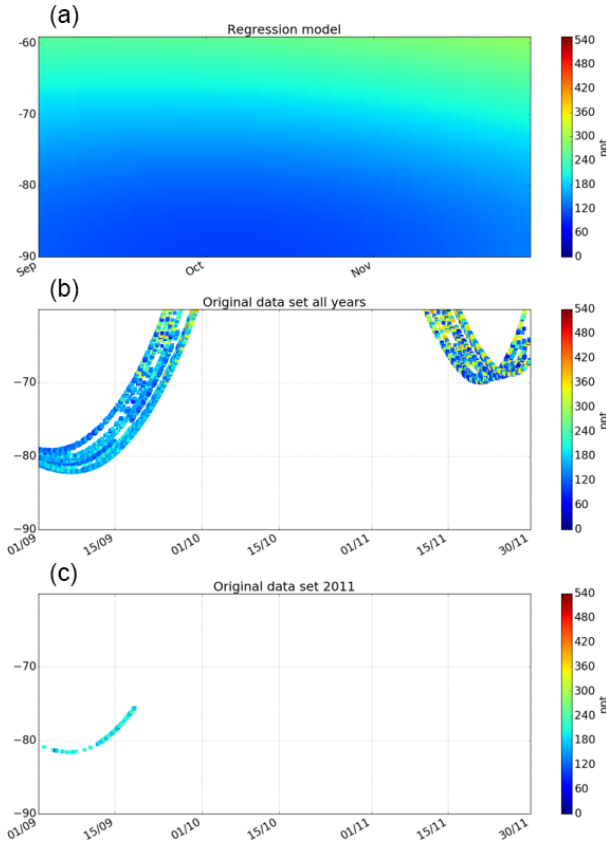
Figure 7. Close-up of the regression model (a) and actual ACE-FTS observations from all years (b) and 2011 (c) for the SON season in the 60–90 ◦ S latitude